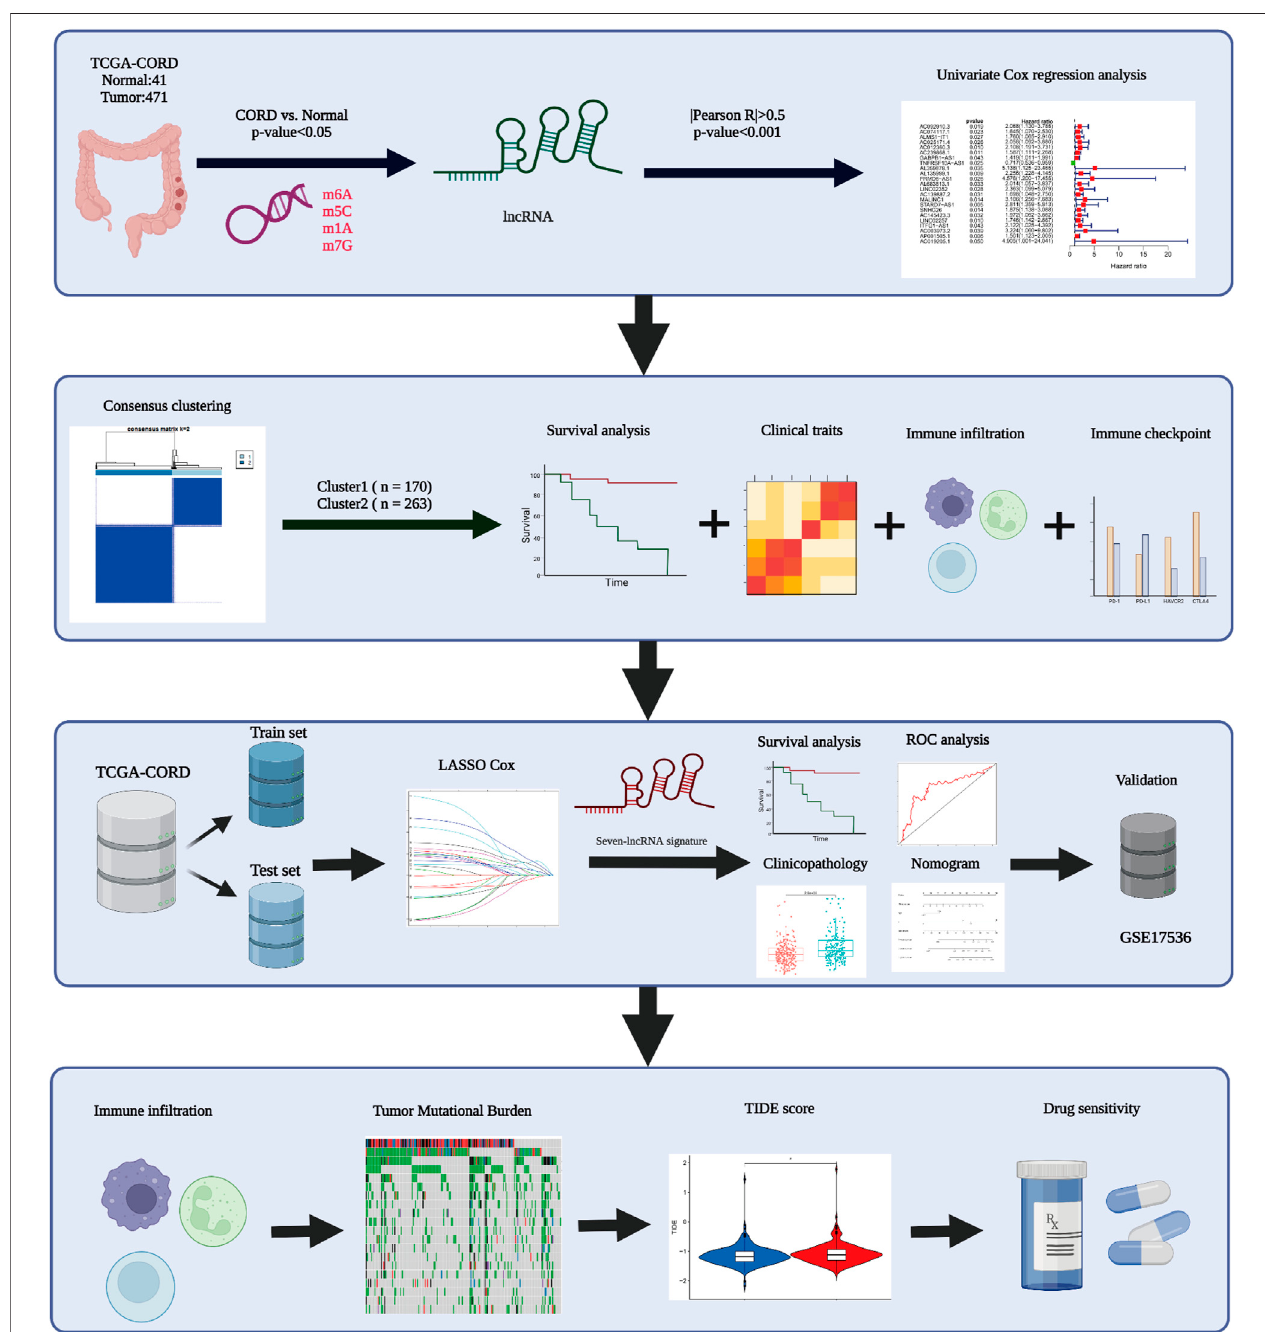
FIGURE 1 | Work fl ow diagram of this